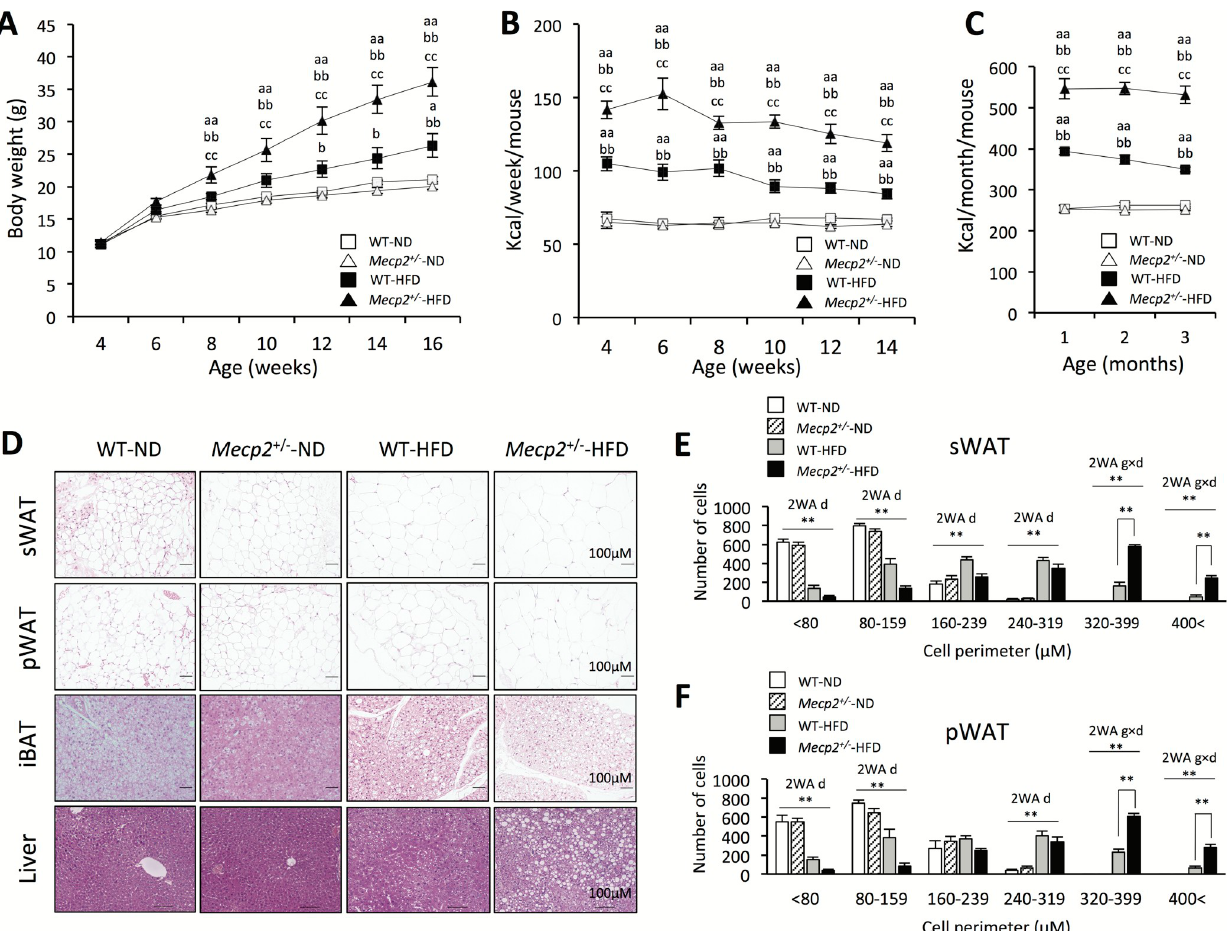
Fig 1. Body weight gain, food intake, and adiposity in Mecp2 +/- mice fed a high-fat diet. (A) Body weight change. (B) Weekly food intake. (C) Monthly food intake. Values are the mean ± SEM for 9–11 mice. (D) Histology of the subcutaneous white adipose tissue (sWAT), perigonadal white adipose tissue (pWAT), brown adipose tissue, and liver. (E) Distribution of adipocyte perimeters in the sWAT. (F) Distribution of adipocyte perimeters in the pWAT. (A– F) Mice were tested at 16 weeks of age; values are the mean ± SEM for 7–8 mice. � = p < 0.05, �� = p < 0.01, a p < 0.05, aa p < 0.01 vs. WT mice fed a normal chow diet (WT-ND). b p < 0.05, bb p < 0.01 vs. Mecp2 +/- mice fed a normal chow diet ( Mecp2 +/- -ND). c p < 0.05, cc p < 0.01 vs. WT mice fed a high-fat diet (WT-HFD). 2WA = Two-way ANOVA, g = genotype, d = diet, Two-way ANOVA followed by post-hoc Tukey-Kramer Multiple-Comparison test.